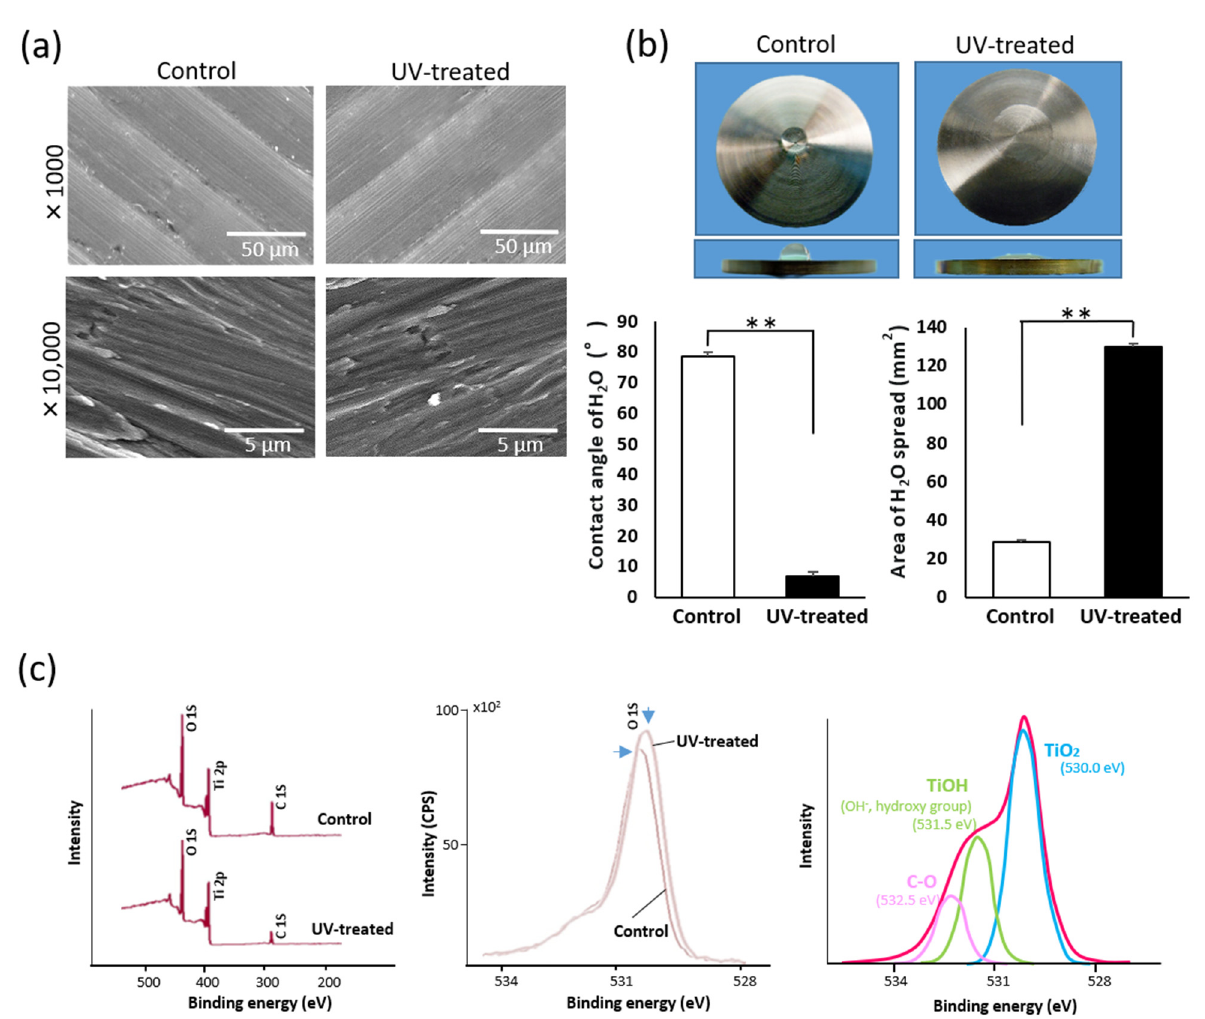
Figure 1. Surface characterization of machined titanium surfaces with and without UV treatment. ( a ) SEM images of four-week-old, machined titanium surfaces with and without UV treatment. ( b ) Hydrophilicity change after UV treatment. Optical images of 10 µL H 2 O droplets pipetted onto titanium surfaces (20 mm in diameter). The histograms show the contact angle and area of 10 µL H 2 O droplets. Data are mean ± SD ( n = 3). ** p < 0.01, statistically significant difference between control and UV-treated surfaces. ( c ) XPS spectra for the untreated control and UV-treated titanium surfaces. The red arrowhead represents the C 1s peak showing a significant difference between the two surfaces (left panel). Comparison of O 1s peaks between the control and UV-treated titanium surfaces (middle panel). Three-peak detailed analysis applied to O 1s peaks. O 1s